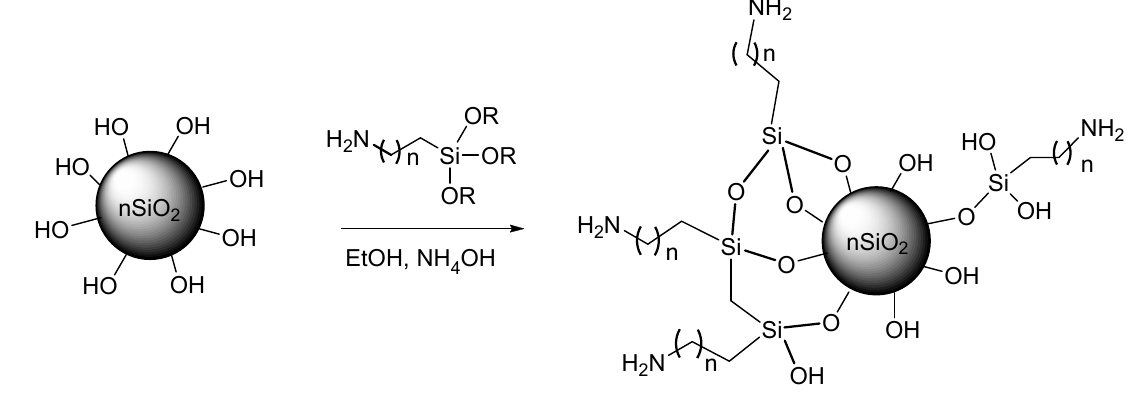
Figure 3. Amino-functionalization of the silica NPs.